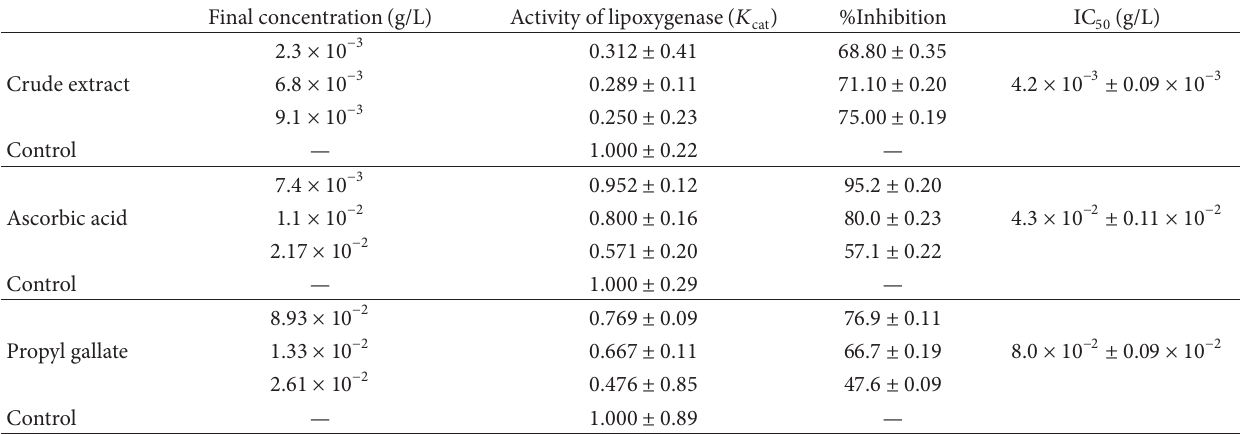
T 2: Results of lipoxygenase effects of crude Gongronema latifolium and two other known antioxidants. Final concentration(g/L) Activity of